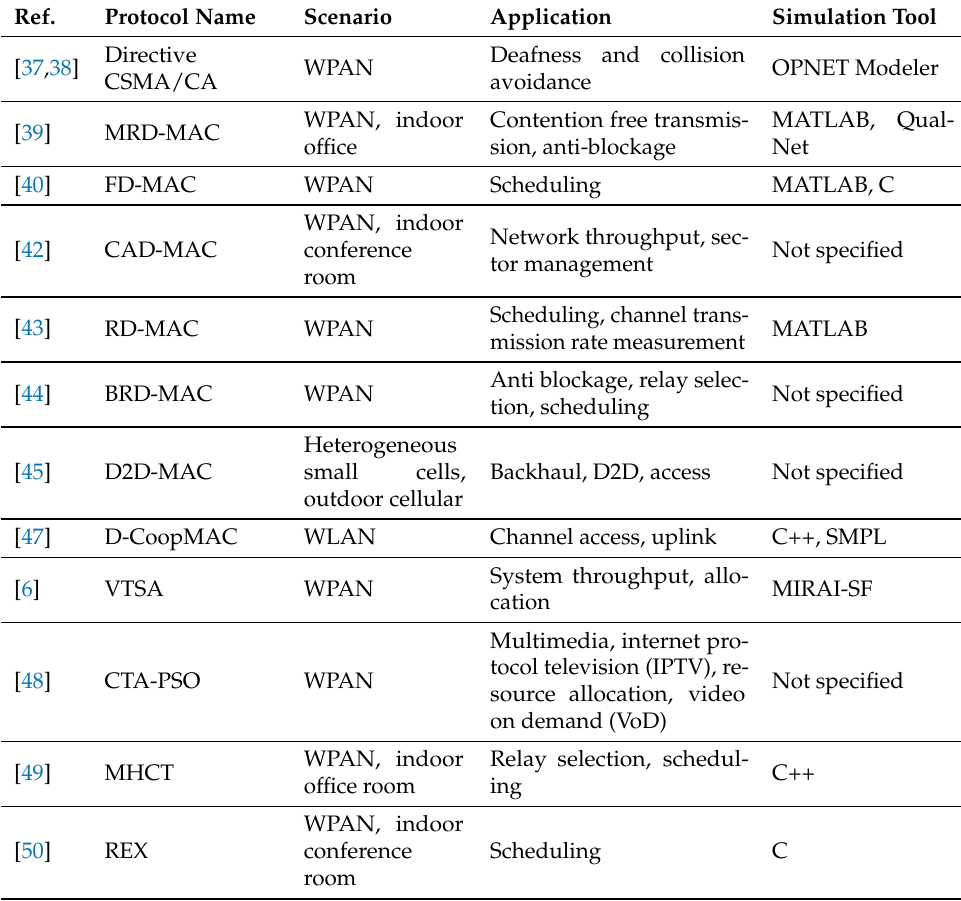
Table 2. Applications of centralized MAC protocols.